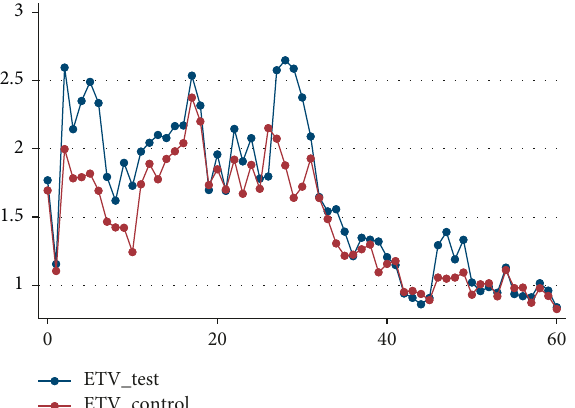
Figure 4: ETV of the test group and the control group. Note. This figure gives the excessive trading volume for the test group and the control group in the subsequent 60 trading days. The red line and blue line represent the excessive trading volume of the test group and the control group,